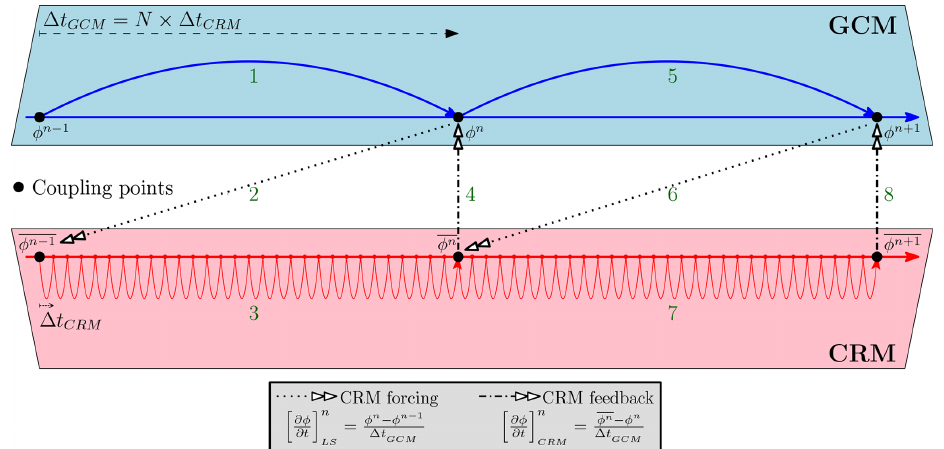
Figure 1. Sketch of model time integration when coupling a host GCM with a superparameterisation (i.e. CRM) based on their prognostic variables φ over a period of two time steps ( n ). A description of the different phases (i.e. numbers) is given in the